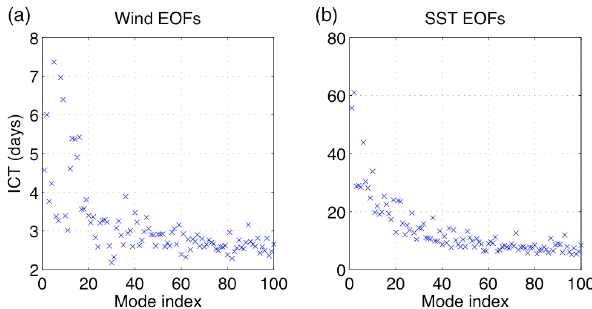
Figure 6. Integral correlation time scales of the leading 100 PCs for: (a) wind, and (b) SST.